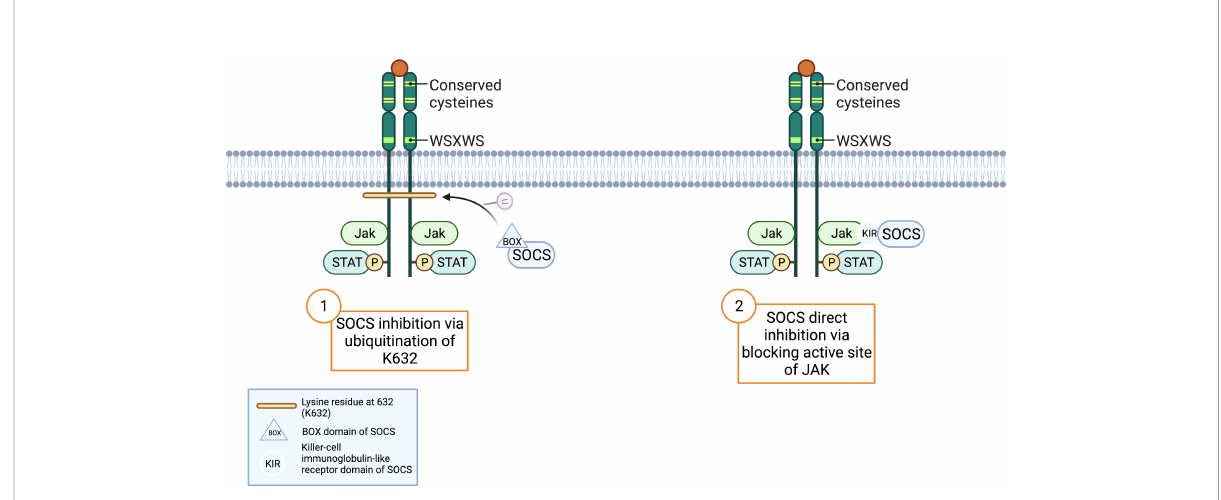
FIGURE 4 SOCS Inhibition Mechanisms. Adapted from “ Cytokine Receptor Families ” , by BioRender.com (2022). Retrieved from https://app.biorender.com/